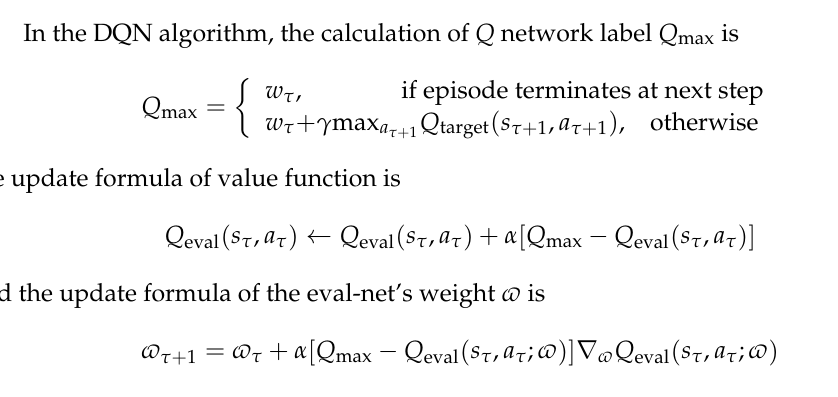
Figure 1. Deep Q -network (DQN) algorithm flow